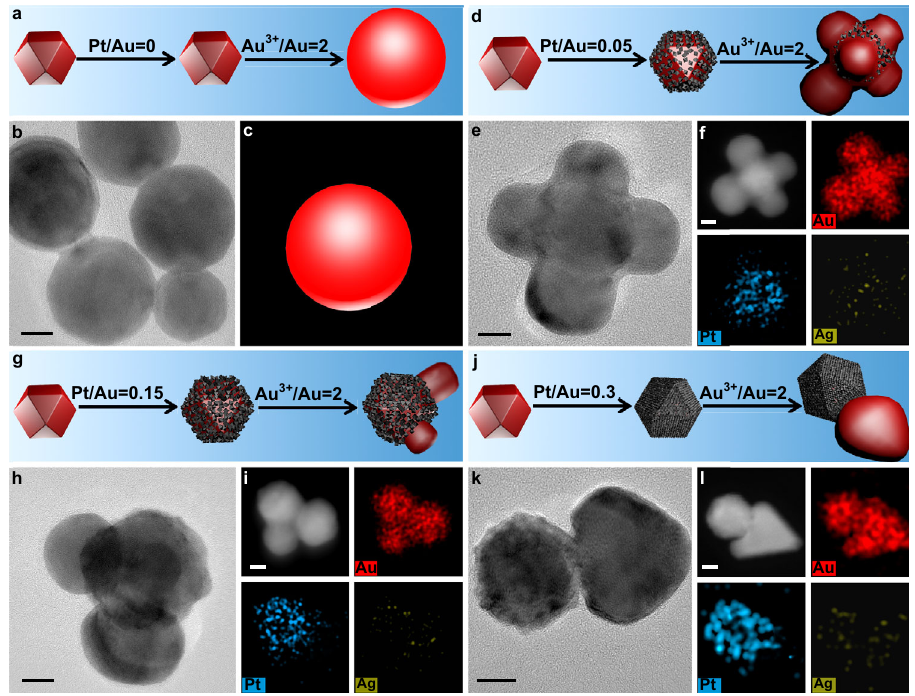
Fig. 6 Au growths on AuTNO@Pt nanocrystals. TEM images, STEM-HAADF images, STEM-EDS elemental maps, and schematic illustrations of products prepared through overgrowing Au on AuTNO@Pt nanocrystals with different molar ratios of Pt and Au: a , b , c 0; d , e , f 0.05; g , h , i 0.15; j , k , l 0.3. All scale bars are 10 nm. In all schematics, the red and gray colors represent Au and Pt,